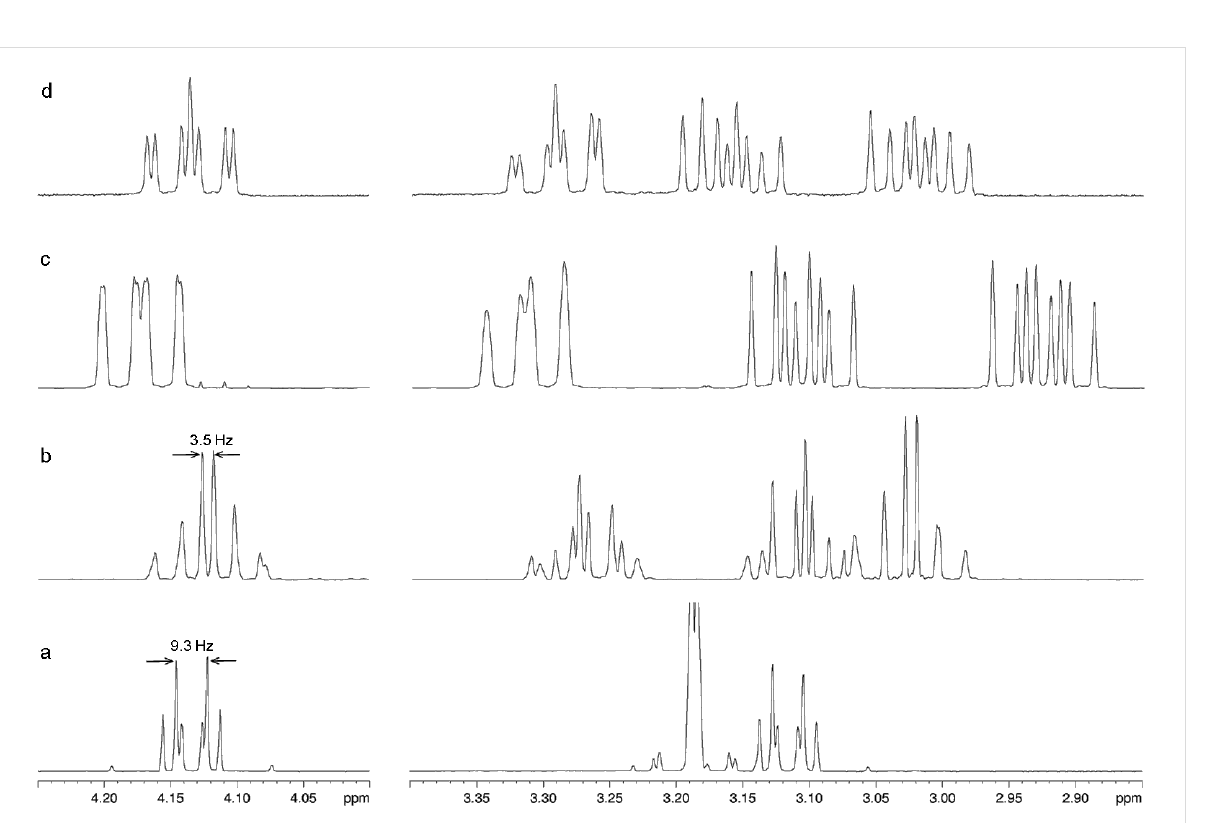
Figure 1: CH 2 CH 2 regions of the 600 MHz 1 H NMR spectra of the isomeric dialdehydes 4 , a: ps-gem , b: ps-meta , c: ps-ortho , d: ps-para isomer.